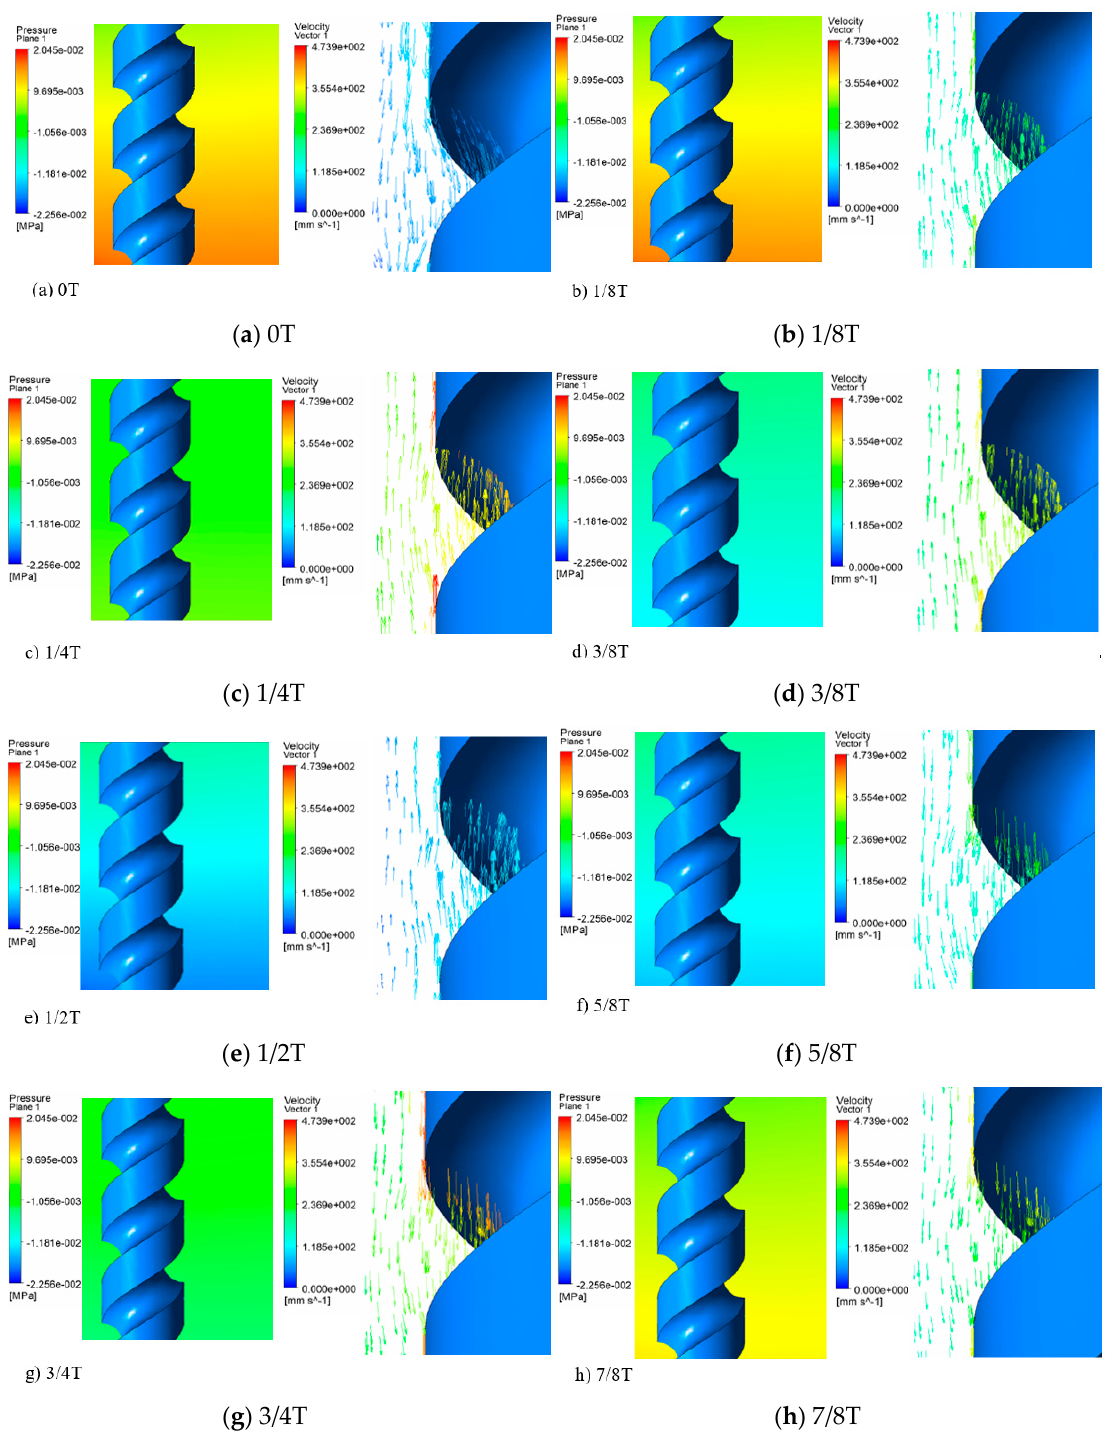
Figure 5. Pressure contours and velocity vector at different times.